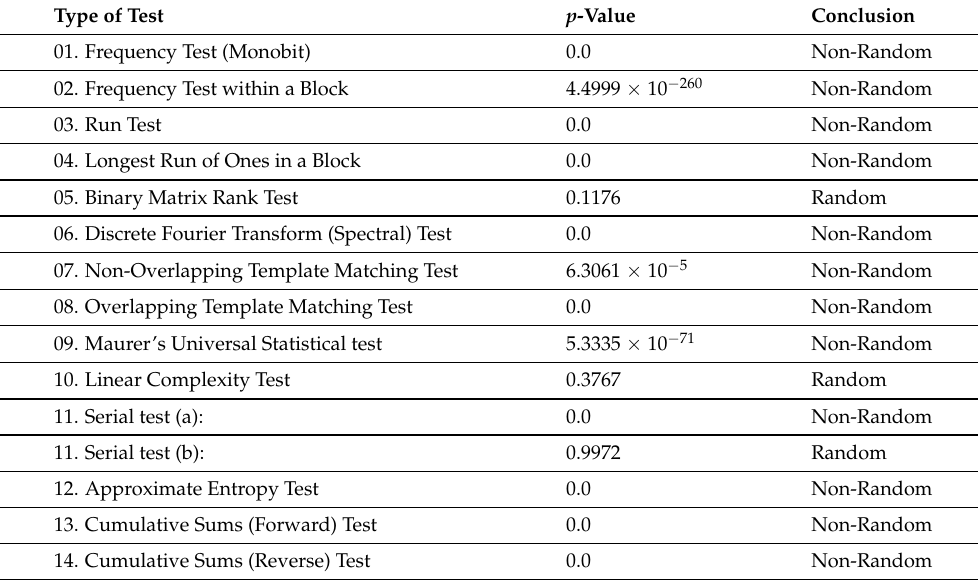
Table 2. NIST randomness tests for sequence ( w 1 n ) n ≥ 0 given by